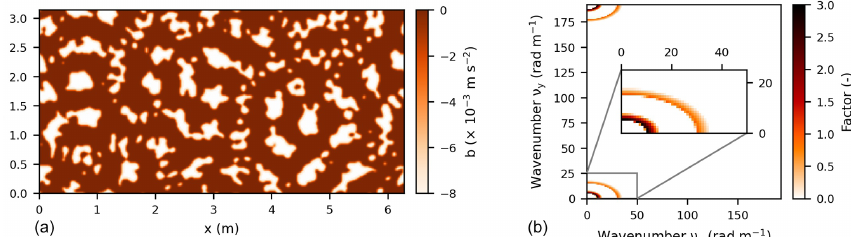
Figure B1. Generated surface temperature and the applied Fourier space in absolute form for the P15m and P15m-NB simulations. The generated surface temperature (a) was obtained by applying the inverse fast Fourier transform in Fourier space (b)